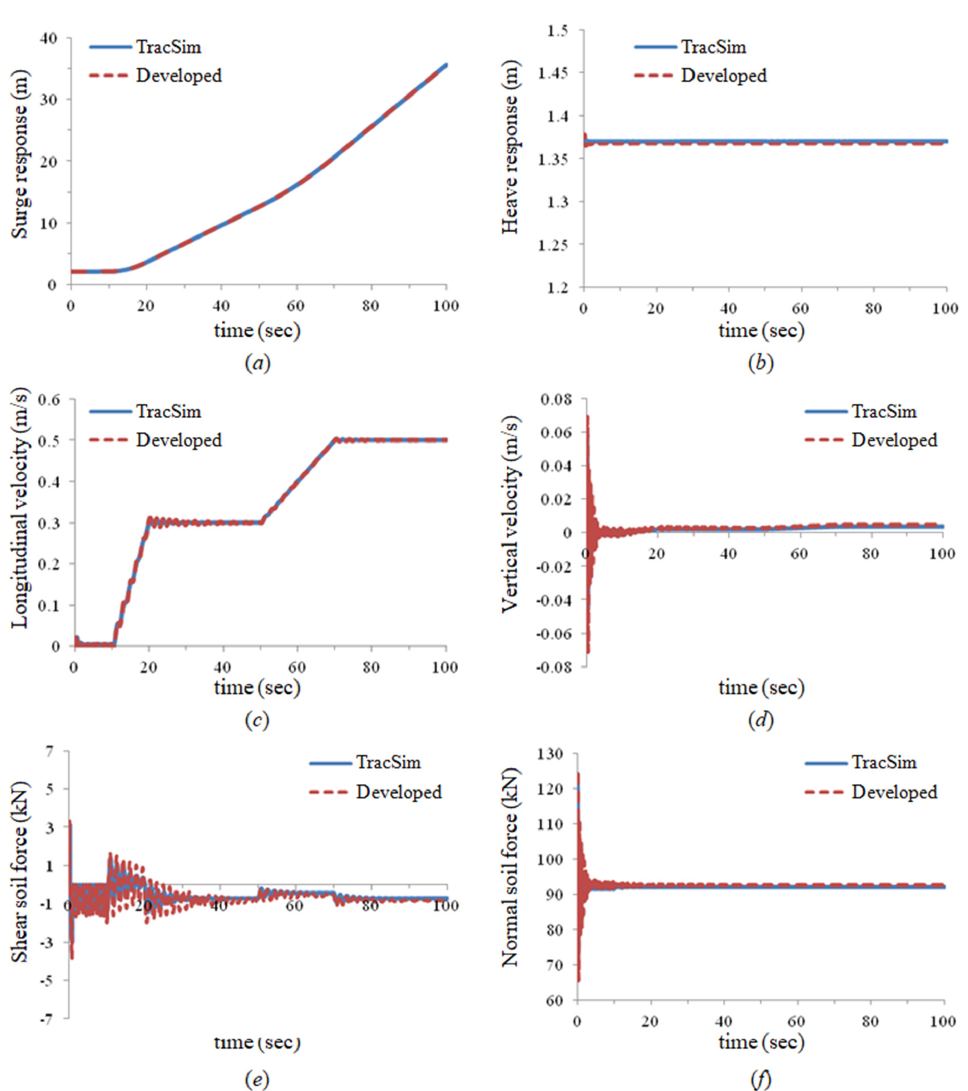
Figure 28. Comparison of the straight drive dynamic analysis results between the developed method and Tracsim: ( a ) surge response of the mining robot, ( b ) heave response of the mining robot, ( c ) longitudinal velocity of the mining robot, ( d ) transverse velocity of the mining robot, ( e ) shear soil contact force acting on mining robot, ( f ) normal soil contact force acting on mining robot.